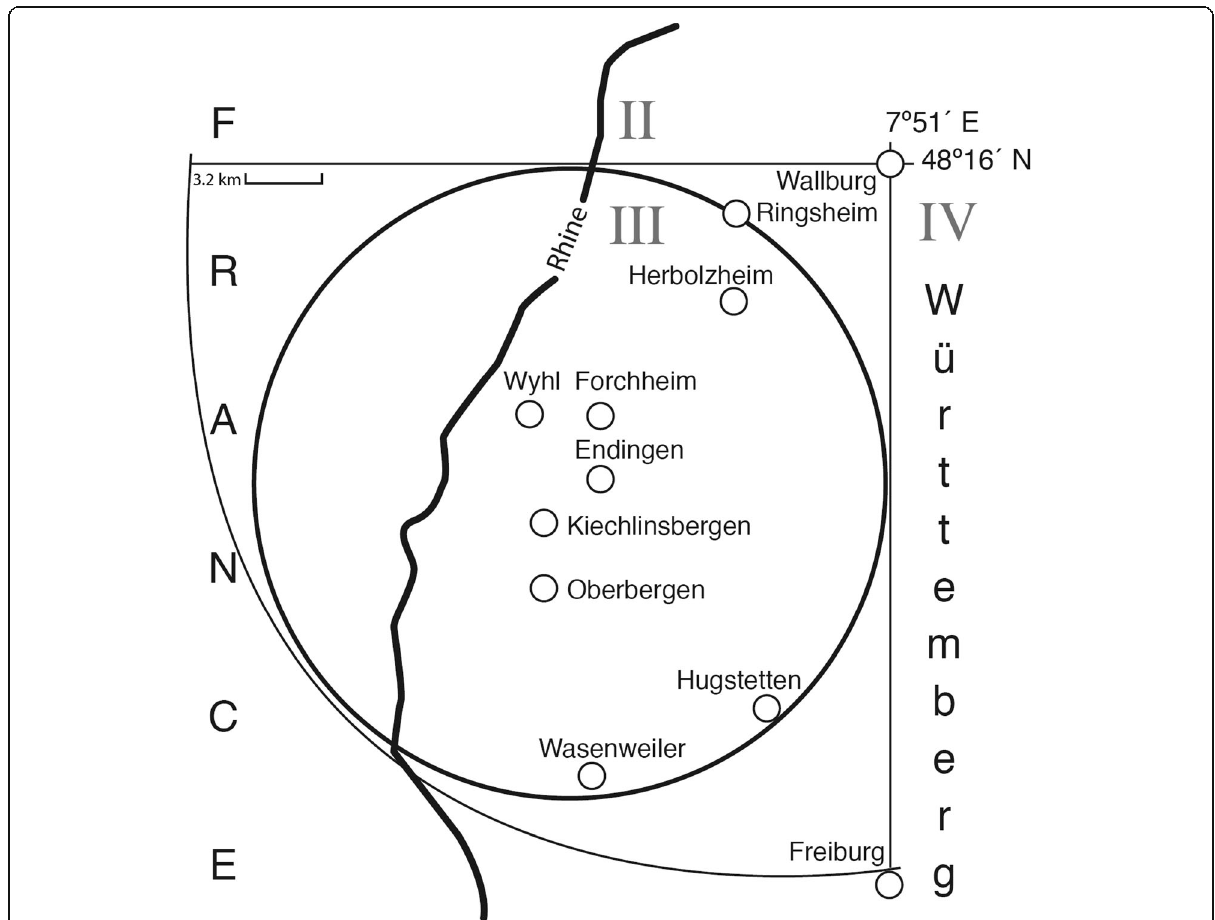
Fig. 2 Kaiserstuhl region eastward the Rhine river in Württemberg state, Germany. Kaiserstuhl region geographic focus III quadrant centered in Wallburg to emphasize the clustering in places of birth within a smaller circular area, for most ancestors of c.35dupG